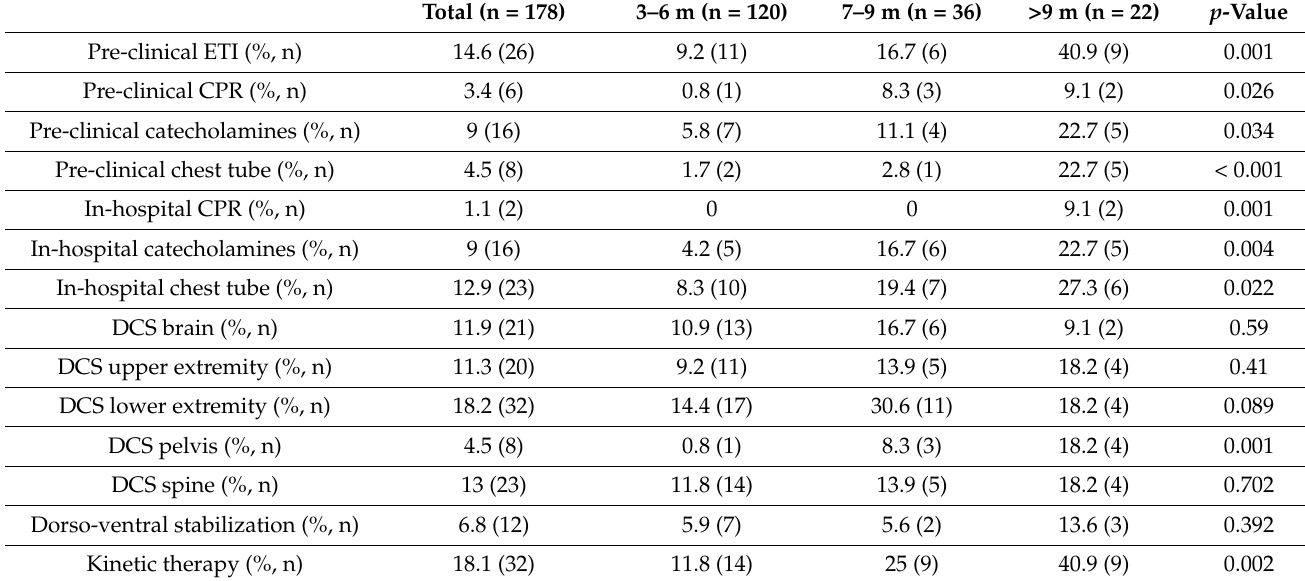
Table 3. Urgent pre- and in-hospital emergency interventions. (ETI: endotrachial intubation, CPR: cardio pulmonary resuscitation, DCS: Damage Control Surgery).